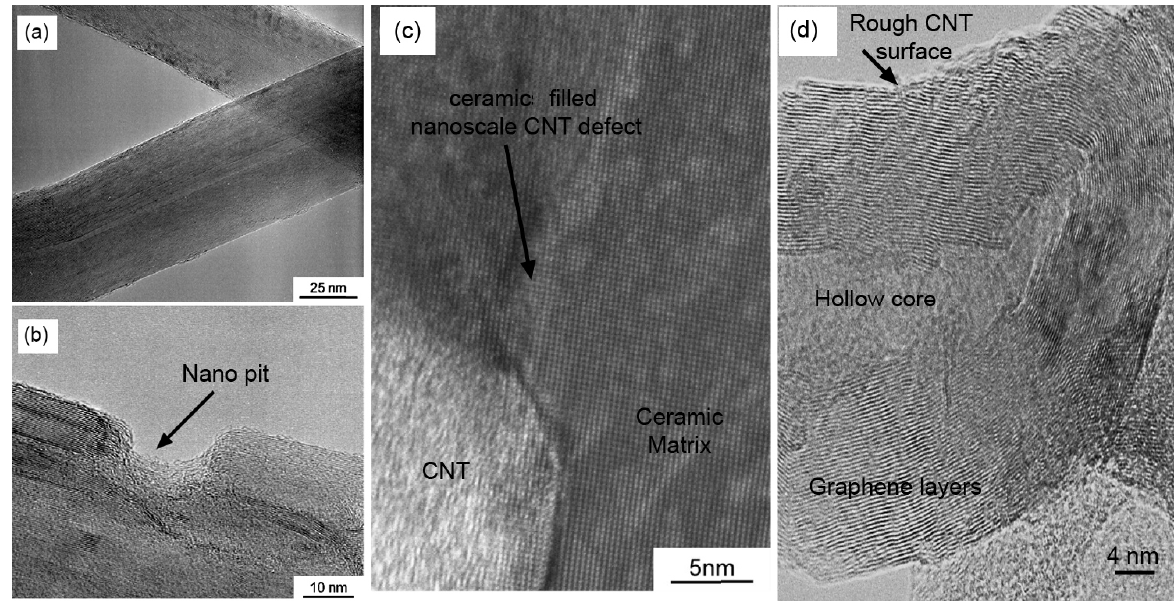
Figure 3. ( a ) TEM image of the pristine MWCNTs; ( b ) High-magnification TEM image